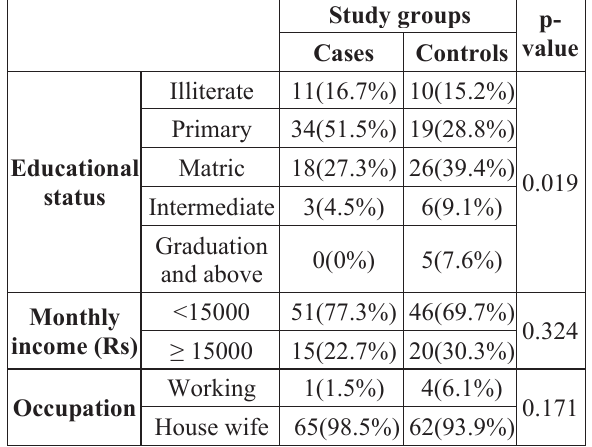
Table-1: Comparison of Educational status, income and occupation among study population (n=132)